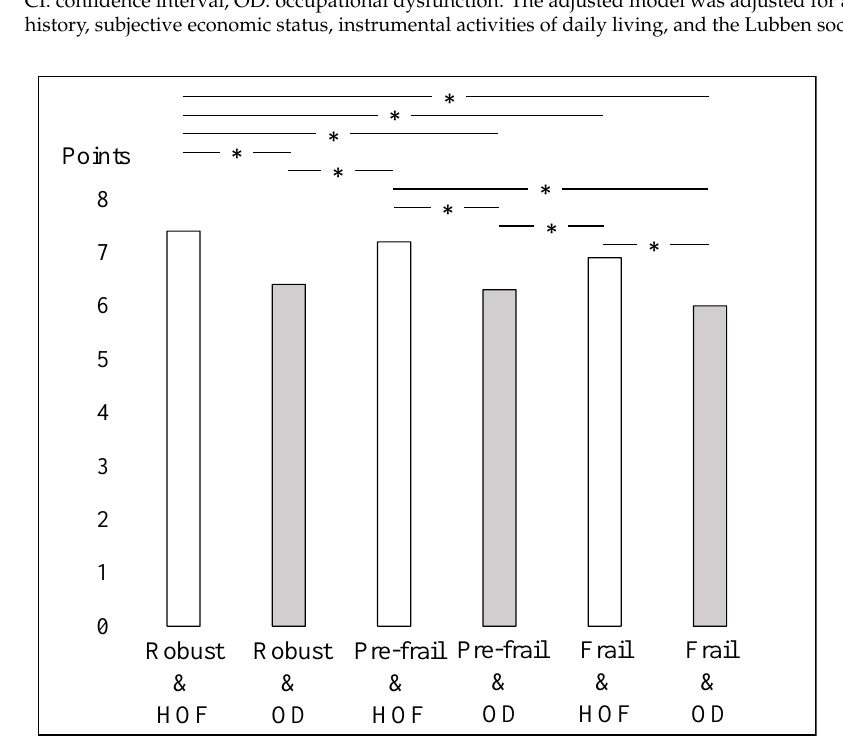
Figure 2. With and without frailty/OD and subjective well-being (adjusted model). * p < 0.05. HOF: healthy occupational function, OD: occupational dysfunction.